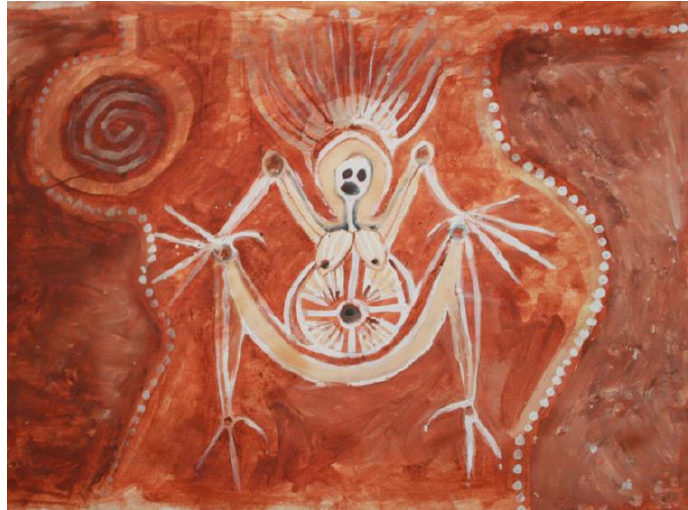
Figure 1. Gunyalungalung Women’s Business; Natural Ochre’s on paper by Belanjee that illustrate the sacredness within cultural place and spiritual space. Location of cave not